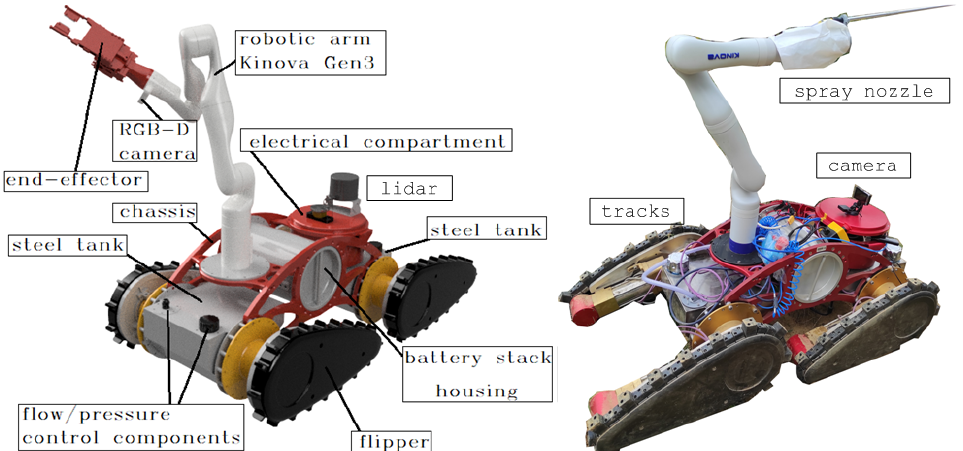
Figure 6. Design of an ATMM consisting of a mobile platform driven by four independently controlled flippers/tracks and a 7-degrees-of-freedom (DoF) robot arm: ( left ) equipped with a gripper for suckering, ( right ) equipped with a spray nozzle for controlled